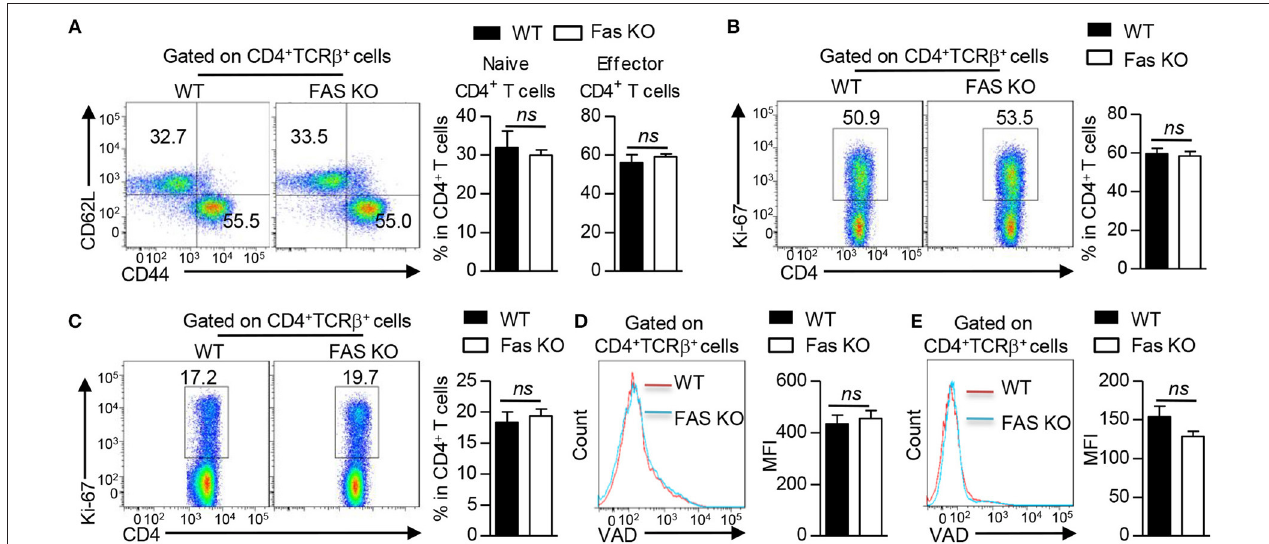
FIGURE 2 | Fas signaling in BMDCs does not affect CD4 + T cell proliferation, apoptosis and activation in vivo. Mice were treated as Figure 1A described. (A) Flow cytometry (left) and proportions (right) of naïve CD4 + T cells (CD4 + TCR β + CD62L + CD44 − ) and effector CD4 + T cells (CD4 + TCR β + CD62L − CD44 + ) in lung tissues. (B,C) Flow cytometry (left) and proportion (right) of Ki-67 expression in CD4 + T cells of lung tissues (B) and mLN (C) . (D,E) Flow cytometry (left) and Median Fluorescence Intensity (MFI) of VAD (right) staining in CD4 + T cells of lung tissues (D) and mLN (E) . ns , not significant. Data are representative of two independent experiments with 4–6 mice per group (A–E) . Student’s t -tests (A–E) were performed and data were presented as mean ±